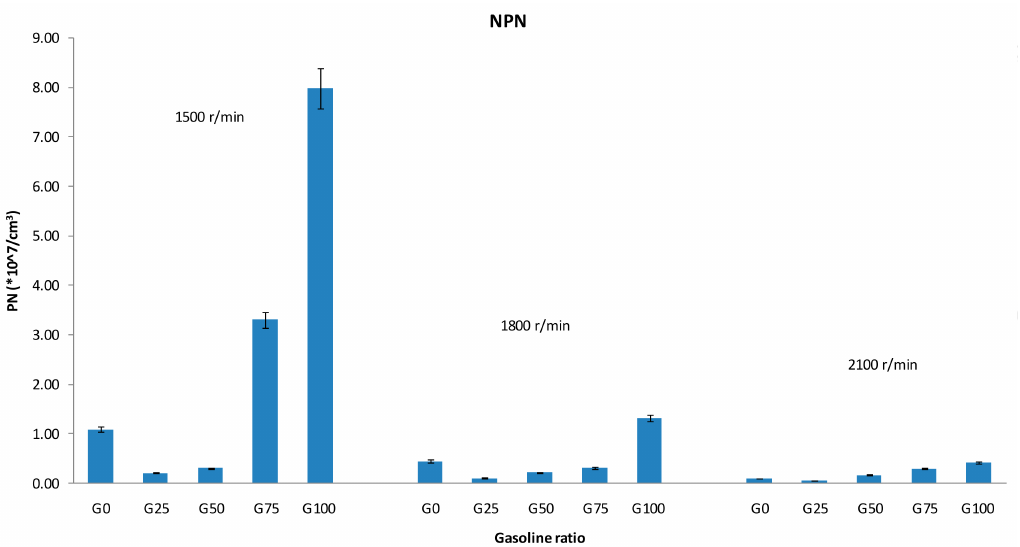
Figure 8. Nucleation mode particle number with R e for di ff erent speed. (The direct injection timing is 180 ◦ CA BTDC. The ignition timing is MBT. The intake manifold absolute pressure is 42